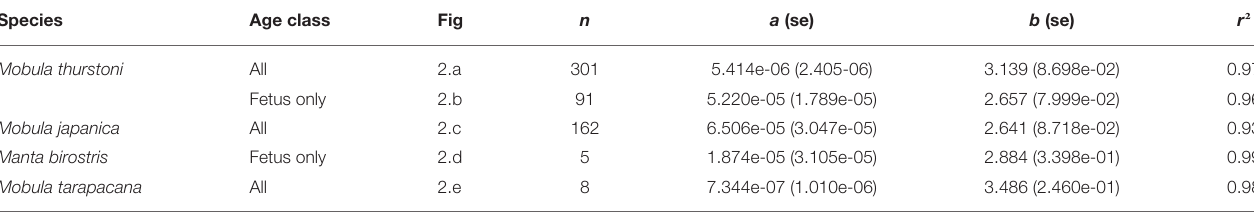
TABLE 4 | Relationship between body mass and disc width. Species